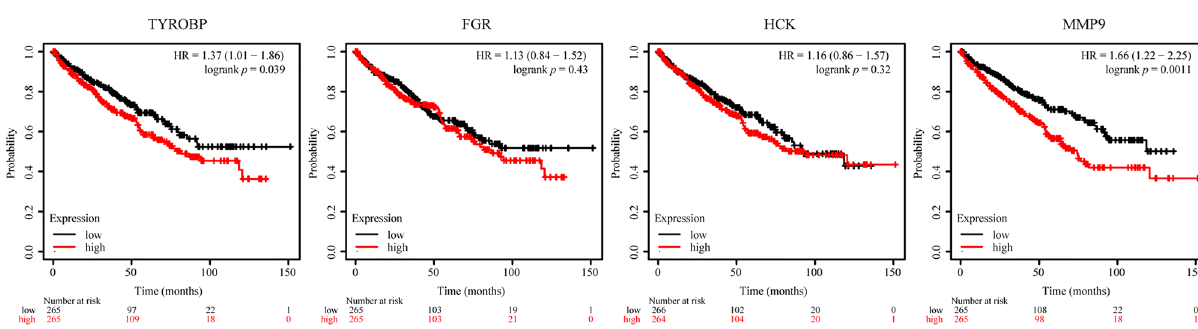
Figure 5. Relationship between key genes and ccRCC OS. OS overall survival, HR hazard